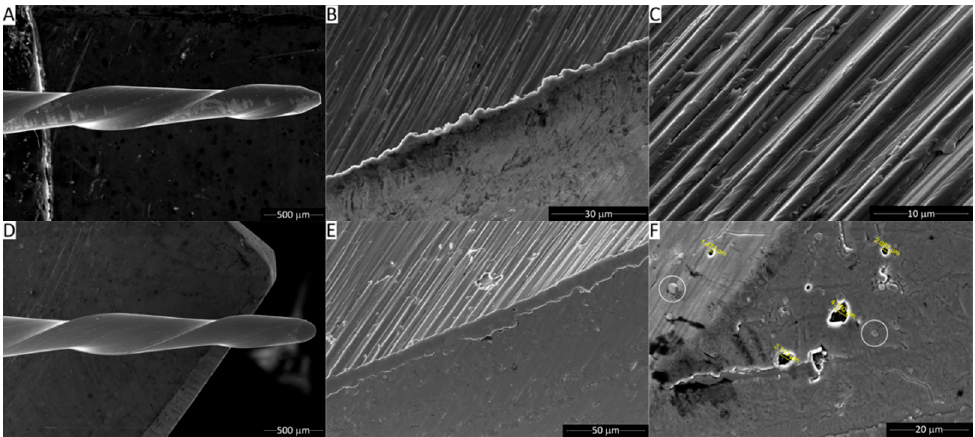
Figure 2. Secondary electron SEM micrographs showing overviews ( A , D ) and details ( B , C , E , F ) of the working area of the Reziflow ( A – C ) and Procodile ( D – F ) files. The circles in panel F indicate clusters.